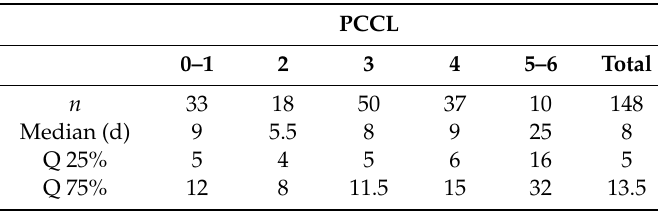
Table 3. Duration of stay (number of days) after surgery and the occurrence of major complications in dependence of